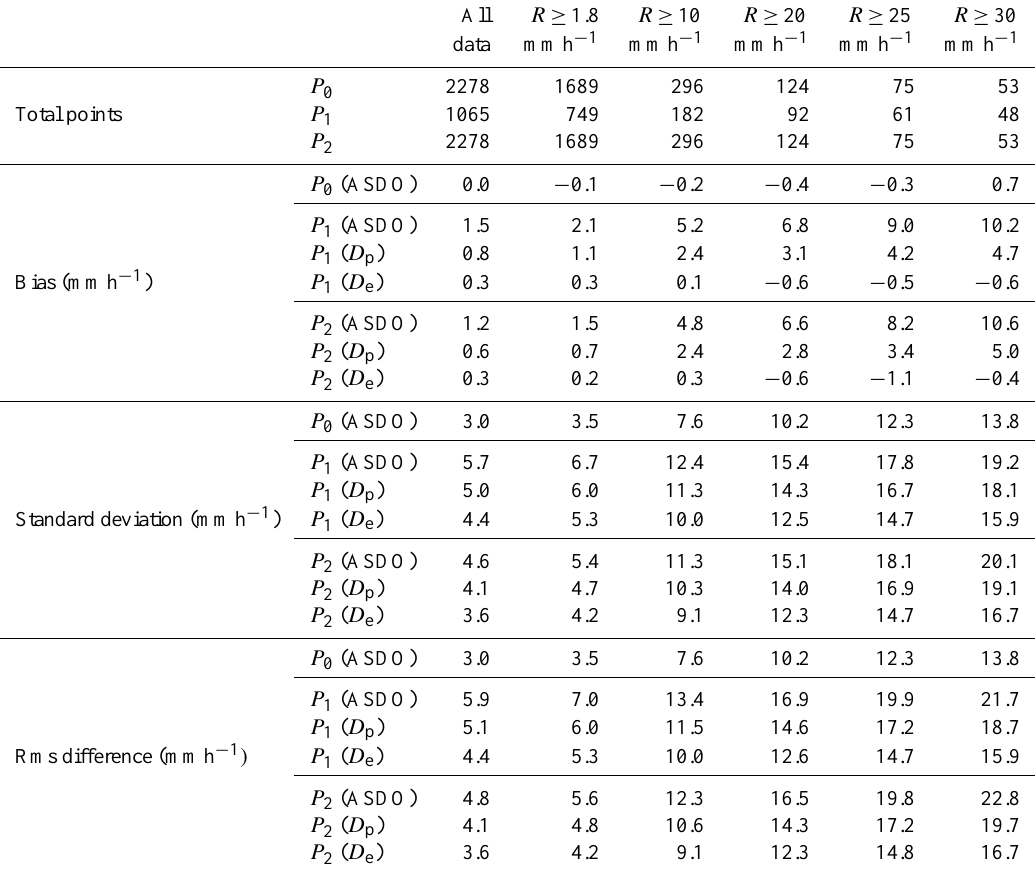
Table A1. Statistical values for the comparison of Parsivel ( P 0 , P 1 , and P 2 ) vs. Pluvio measurements of the (top) total points, (2nd row) bias, (3rd row) standard deviation, and (bottom) root mean square of the rainfall rate differences. Rainfall rate data were derived from on-board software (ASDO) and from the DSD with the preset diameters ( D p ) and with the re-calculated equivalent volumetric diameters ( D e ).